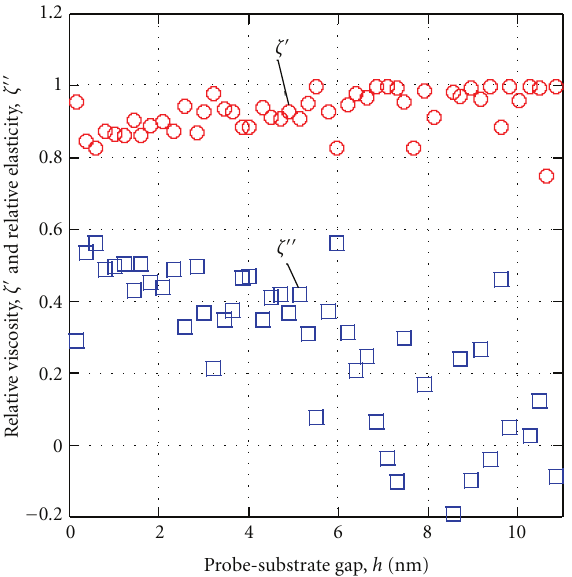
Figure 14: Relative viscosity and elasticity of Zdol4000 with a bonding ratio of 0.2 in the separating process at h < 11nm